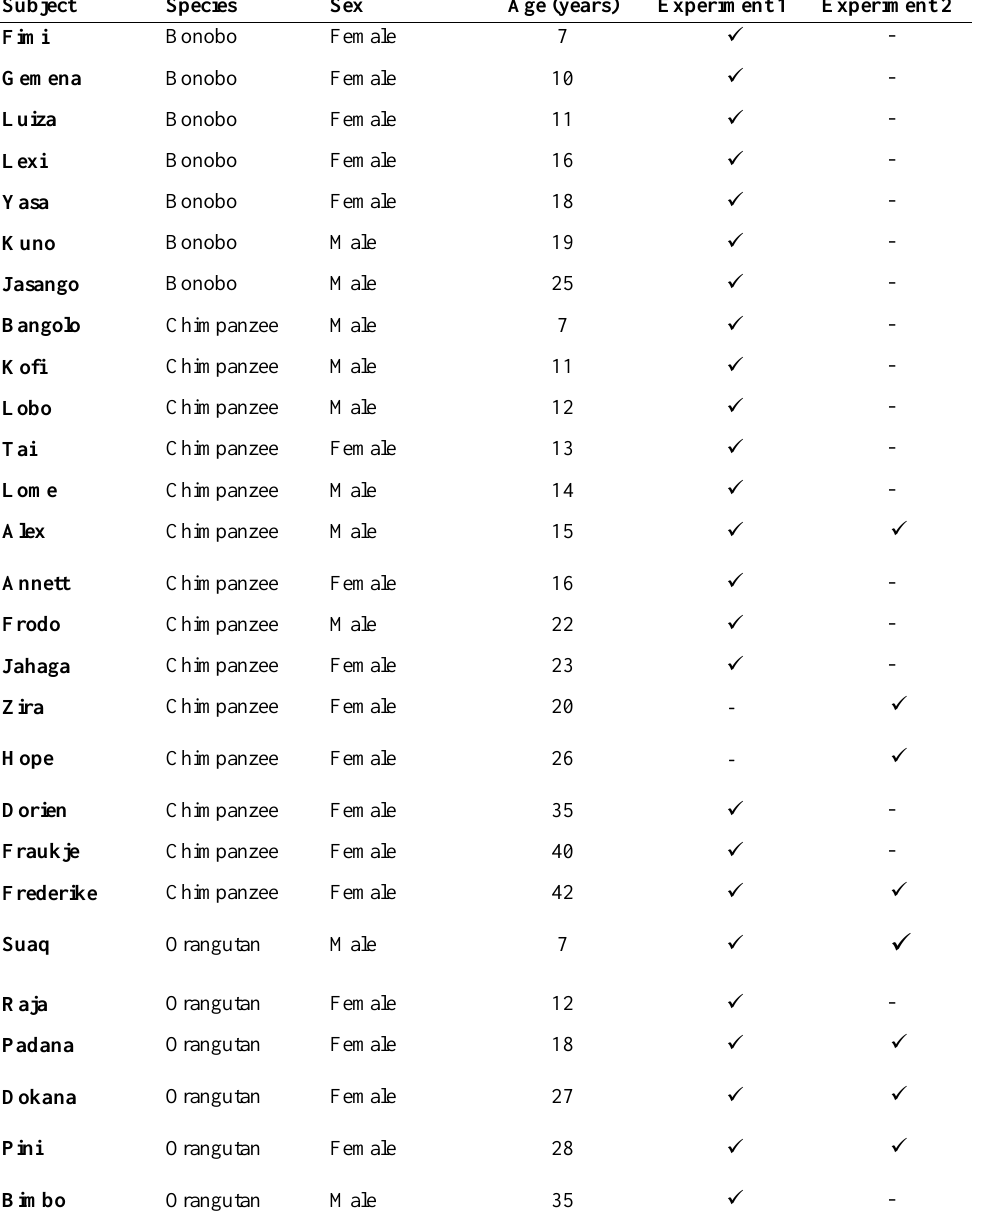
Participation of Subjects by Experiment .